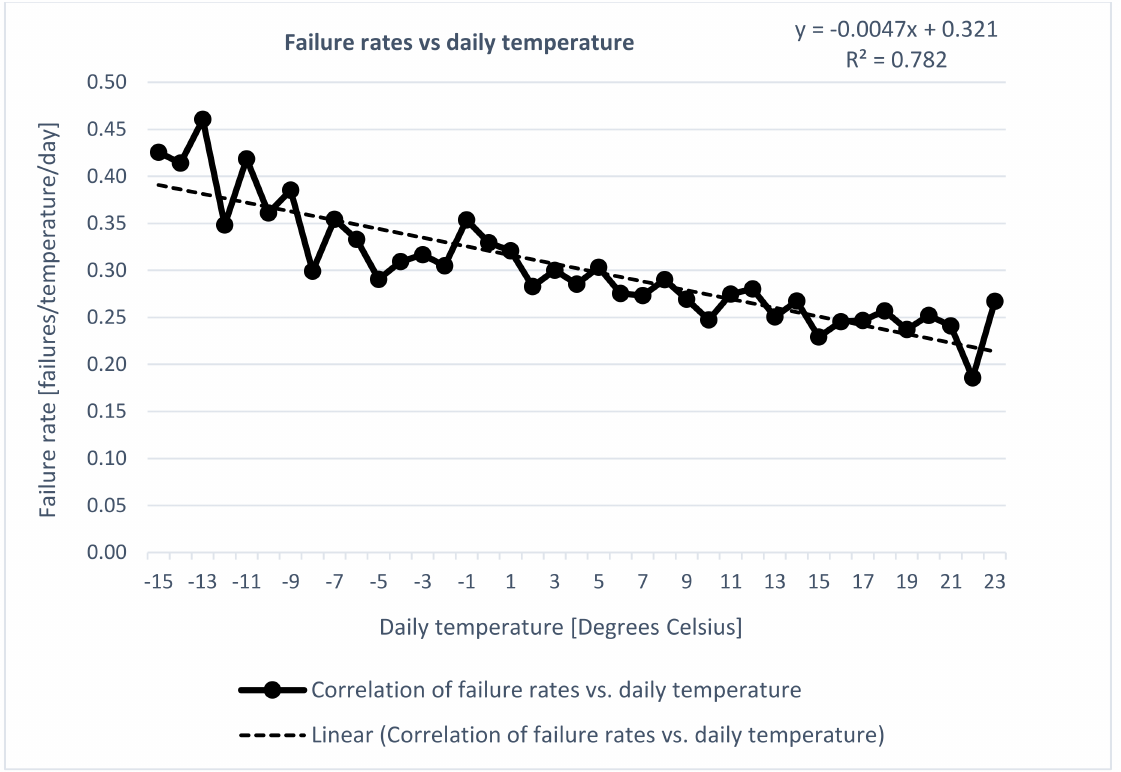
Figure 5. Linear regression showing the correlation between failure rates and